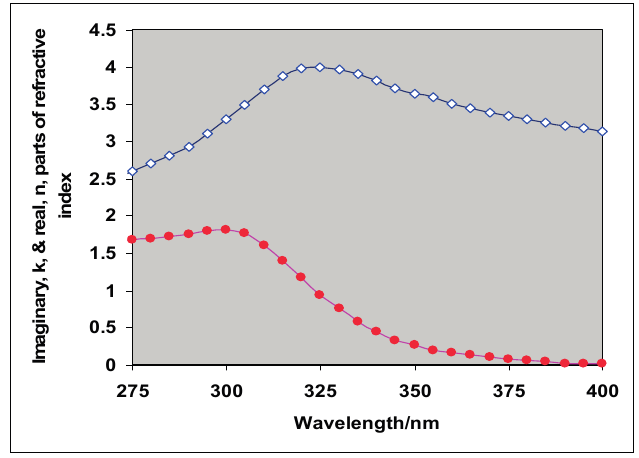
Figure 2. Variation of the real, ◊ , and imaginary, ● , components of the refractive index of rutile between 275 and 400 nm based on results of Vos and Krusmeyer [22]. Above 400 nm the imaginary component, which controls light absorption, is negligible even though the real component is not. Pure rutile crystals are transparent in the visible region of the spectrum but can scatter visible